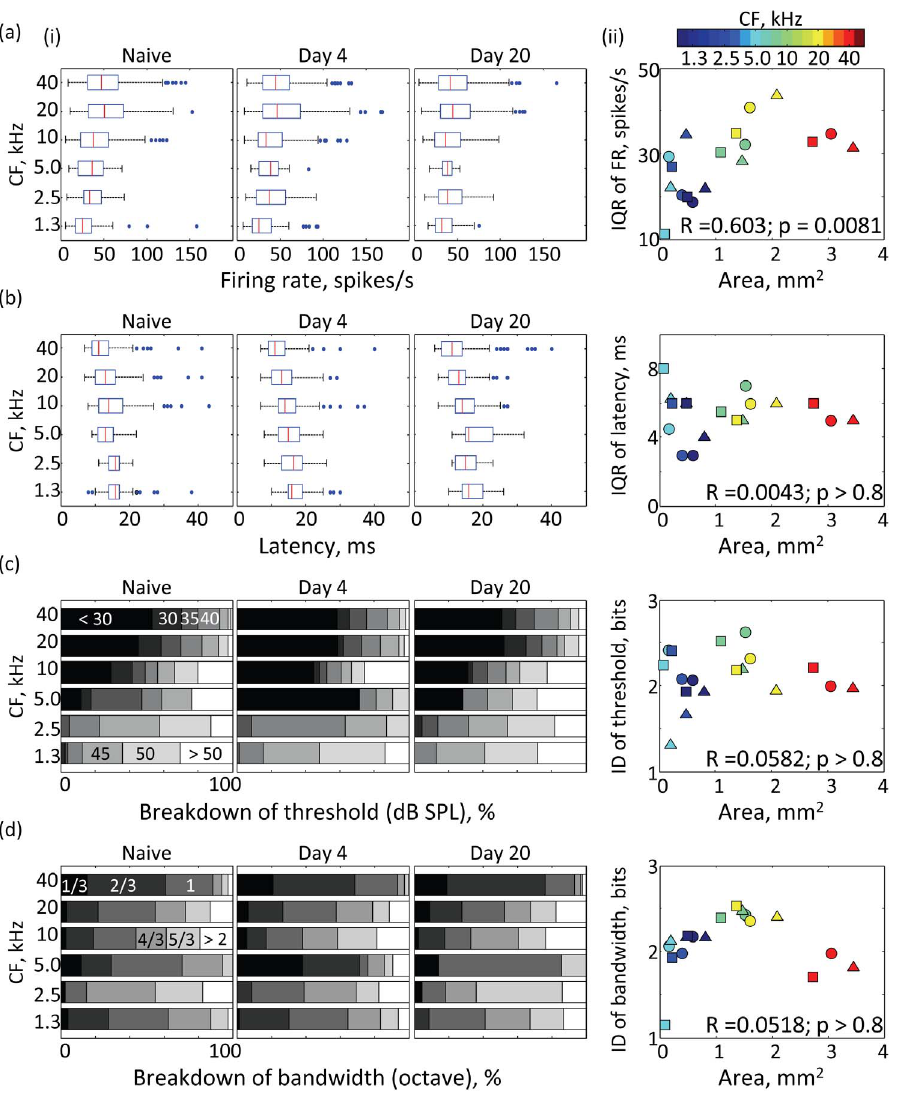
Figure 5. Distribution of conventional properties in tone-evoked neural responses and FRA. (a) Peak firing rate; (b) Peak latency; (c) Threshold; (d) Bandwidth. (i) CF-dependent distribution in each test group (naı¨ve, day4 and day 20). Breakdown lists, instead of boxplots, are used to characterize the threshold (c) and bandwidth (d) because these properties are discretized. Proportions of subgroups of threshold (in dB SPL) and bandwidth (in octave) are shown in discrete grey levels as indicated in the left inset. (ii) Variance of response property with respect to representational area with a given CF. IQR was used to quantify the variances of firing rate (a) and latency (b), whereas the Shannon index of diversity (ID) was used in discrete properties of the threshold (c) and bandwidth (d). Other conventions comply with Fig.